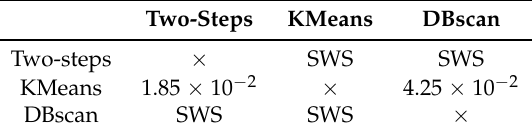
Table 11. p -values for instance a.5.